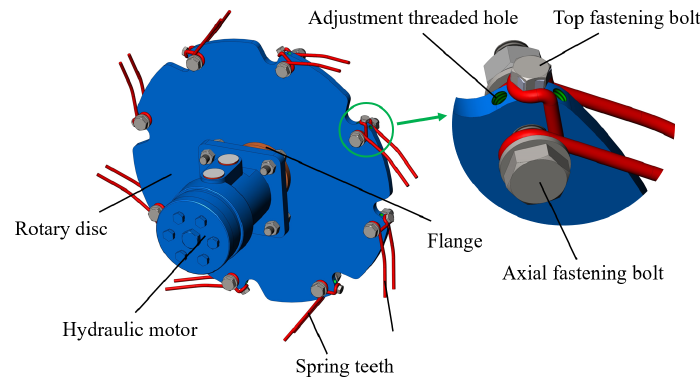
Figure 4. Structural diagram of side throwing mechanism.